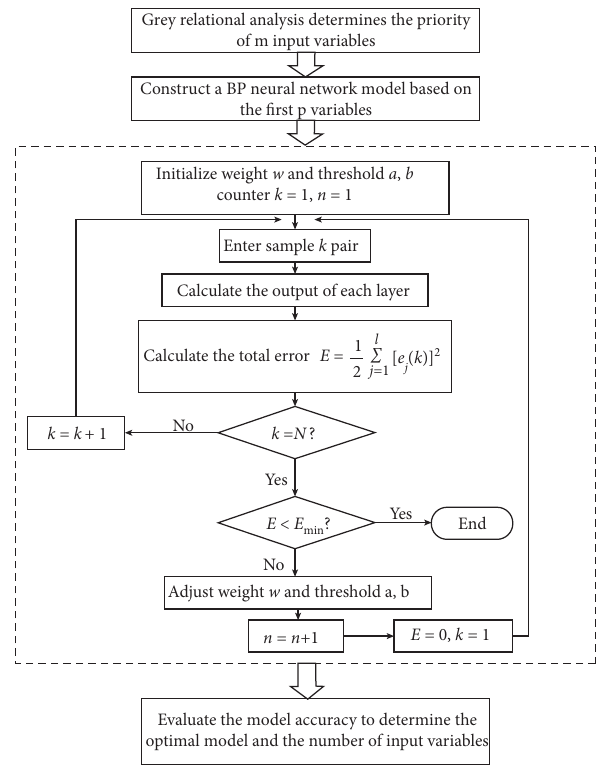
Figure 2: Flow chart of the variable optimization selection